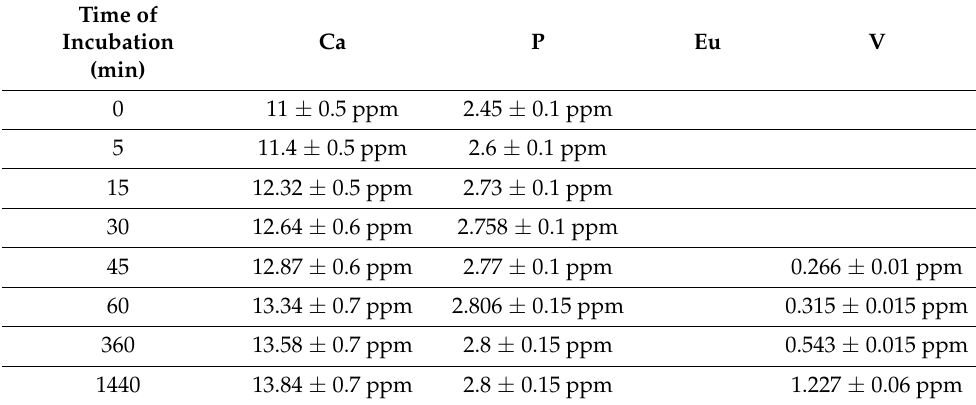
Table 2. The Ca, P, Eu, and V ion release from Ca 9.9 Eu 0.1 (PO 4 ) 5 (VO 4 ) 1 (OH) 2 to the simulated body simultaneous rotation.